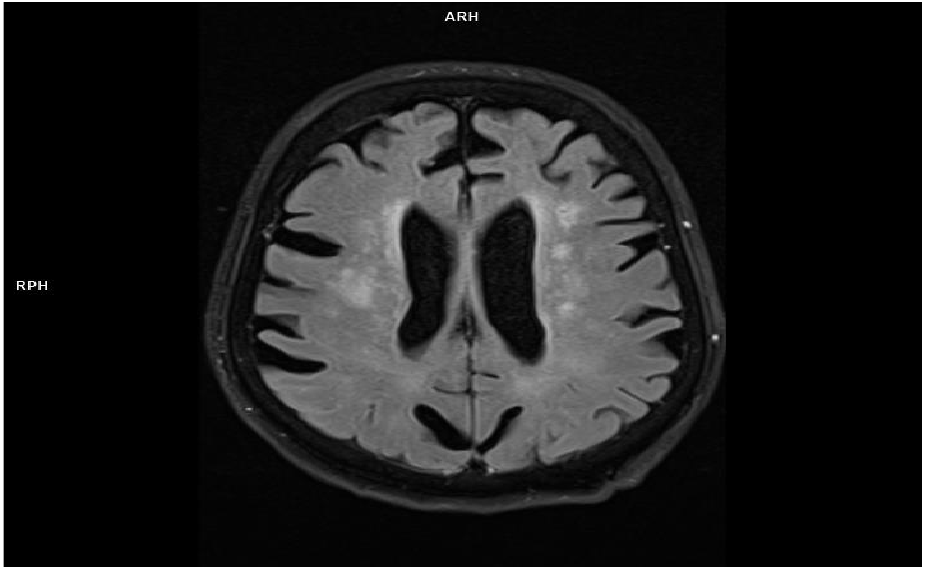
Figure 1. Cortical-subcortical atrophy with the diffuse hyperintense areas of the white matter (small vessel disease) — Flair sequence (MRI imaging).